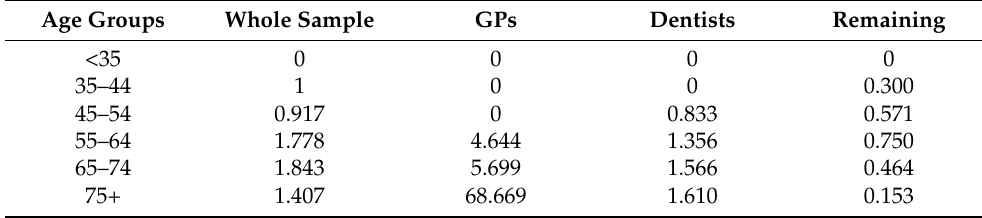
Table 4. Standardized Mortality Rates